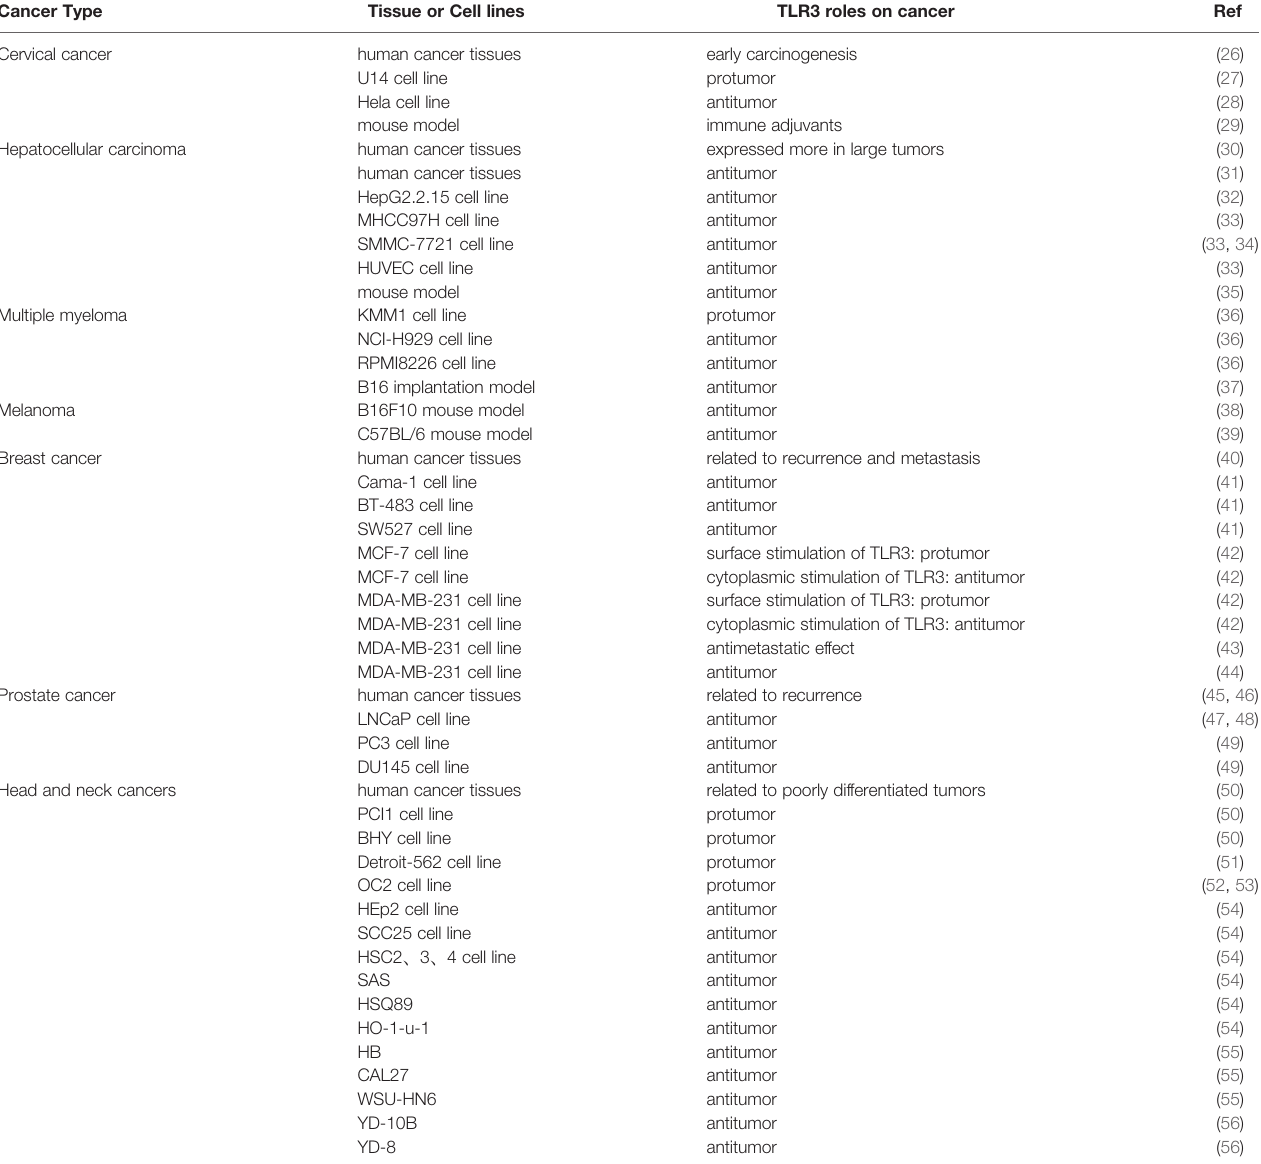
TABLE 1 | TLR3 expressions in human